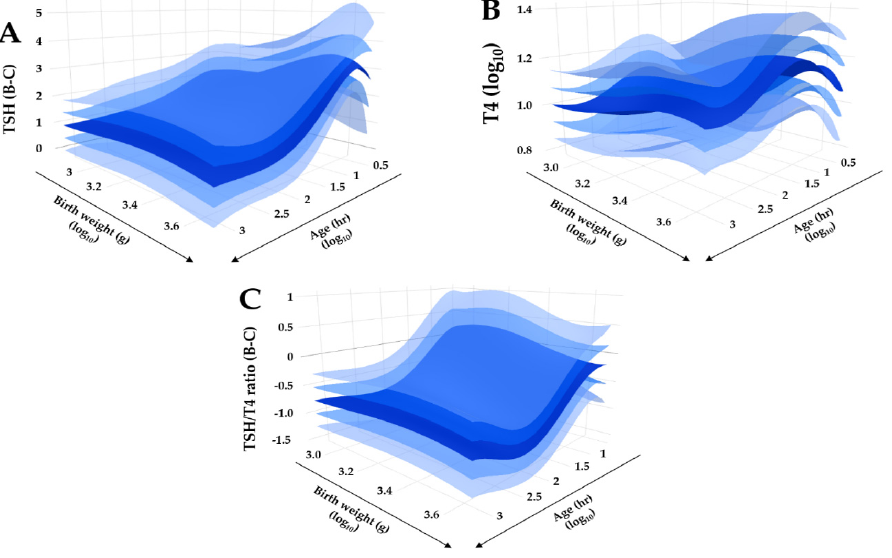
Figure 6. Regression quality control plot of covariate adjusted TSH, T4, and TSH/T4 ratio. Legend: Bi-dimensional plots in a tri-dimensional space of adjusted reference intervals. (Panel A ): TSH, Box-Cox transformation; (Panel B ): T4, log10 transformation; (Panel C ): TSH/T4 ratio, Box-Cox transformation. Primary covariate is age (right lower axis), secondary covariate is birth weight (left lower axis). The dark blue surface represents the median, lighter blue surfaces represent one and two standard deviations above and below the median, respectively.